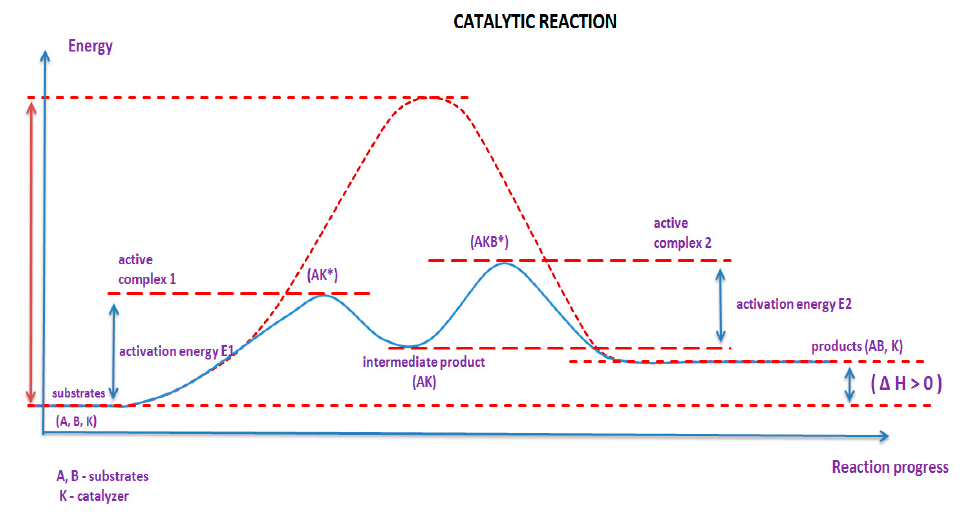
Figure 3. Course of chemical reaction with catalyst.